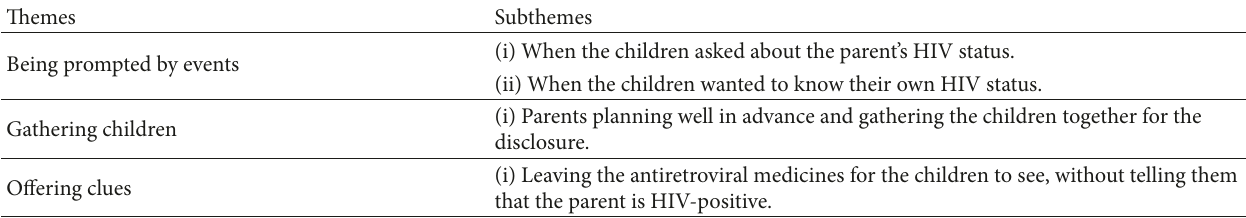
Table 4: Some processes of disclosure, as presented by the patients that had disclosed their HIV status to their children. Themes Being prompted by events Gathering children